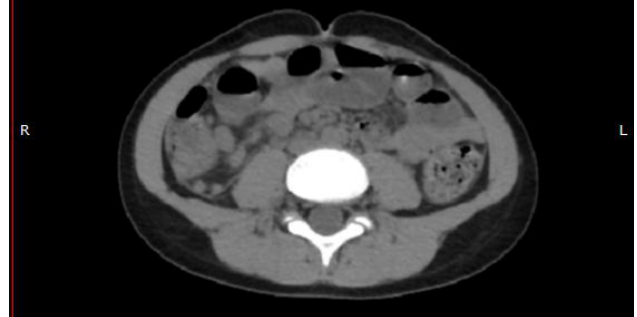
Figure (1): CT scan showing multiple enlarged matted mesenteric lymph nodes clustered at the right iliac